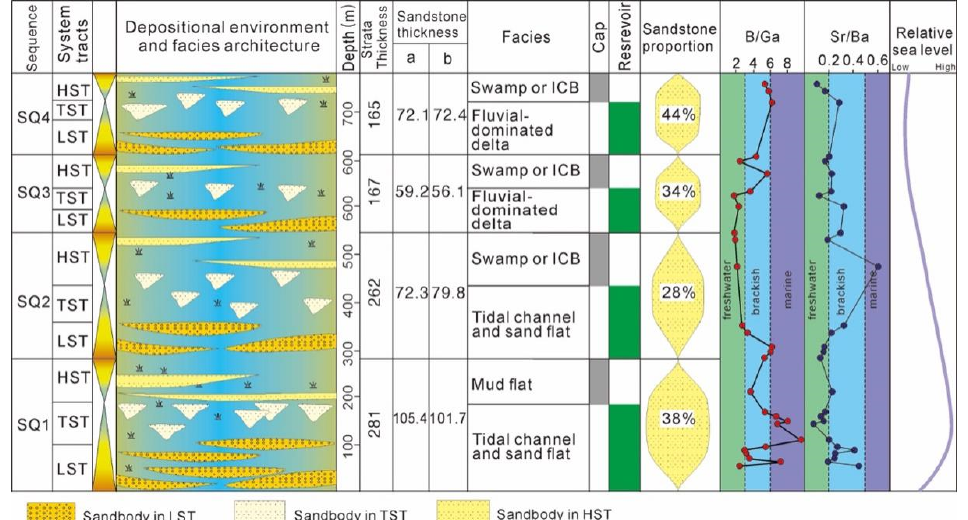
Figure 15. Synthetic chart of the Pinghu Formation in the Xihu Sag, showing the sedimentary environment and facies architecture, potential reservoir, sea interval, and vertical distribution of the sand body. ICB = inter-channel bay. The sandstone thickness, a, represents the calculated sandstone based on drill core data; b represents the sandstone thickness calculated based on the prestack inversion process. The threshold of B/Ga and Sr/Ba was modified from [95].